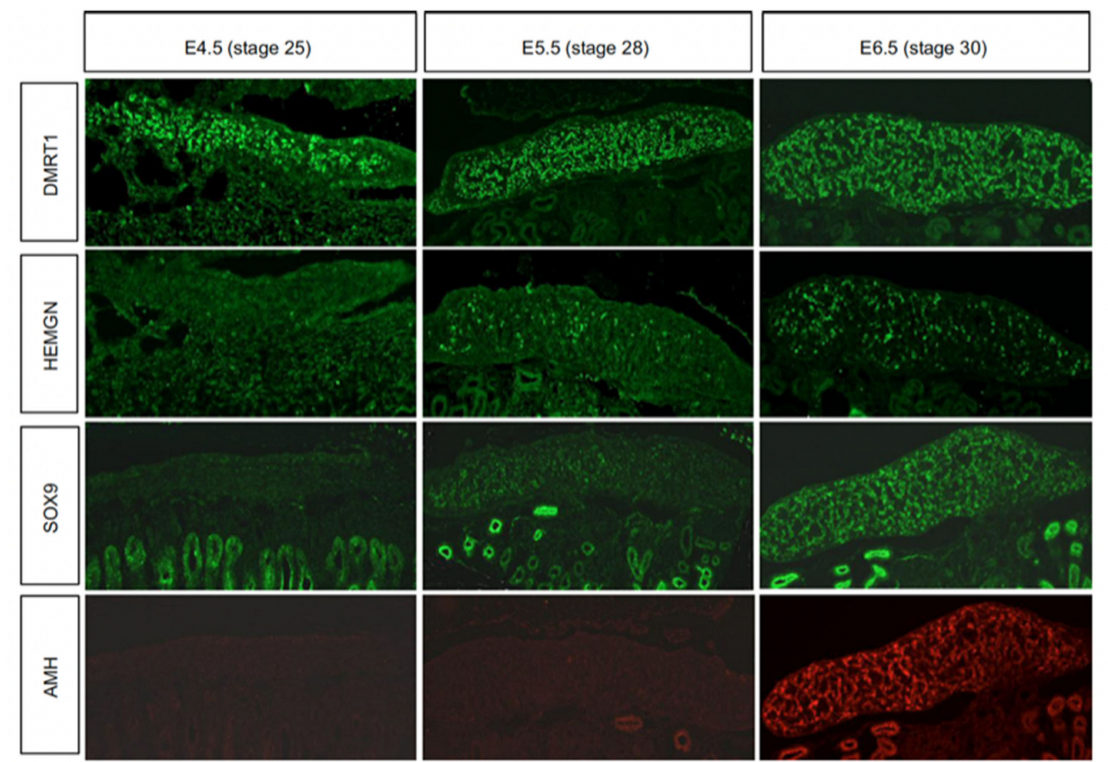
Figure 4. Chronology of marker protein expression in embryonic male chicken gonads at the onset of sexual differenti- ation.Immunofluorescence staining for DMRT1 (green), HEMGN (green), SOX9 (green) and AMH (red) proteins in E4.5 (HH25), E5.5 (HH28) and E.6.5 (HH30) embryonic gonads. DMRT1 shows robust expression from at least as early as E4.5. Both HEMGN and SOX9 are expressed from E.5.5 (stage 28), and AMH protein is detectable at E6.5 (stage 30-31). Scale bar = 100 µ m. Reproduced from Lambeth et al., (2014) with